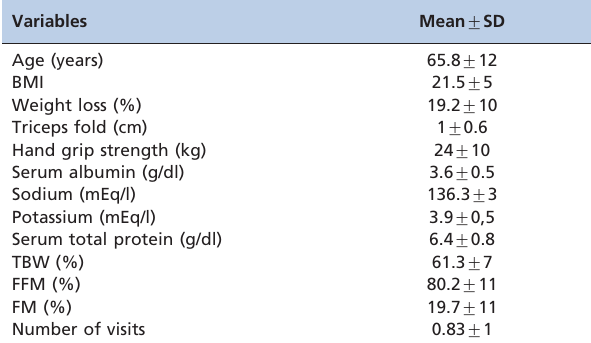
Table 1 - Characteristics of the study population (total number of patients with UADT= 34).